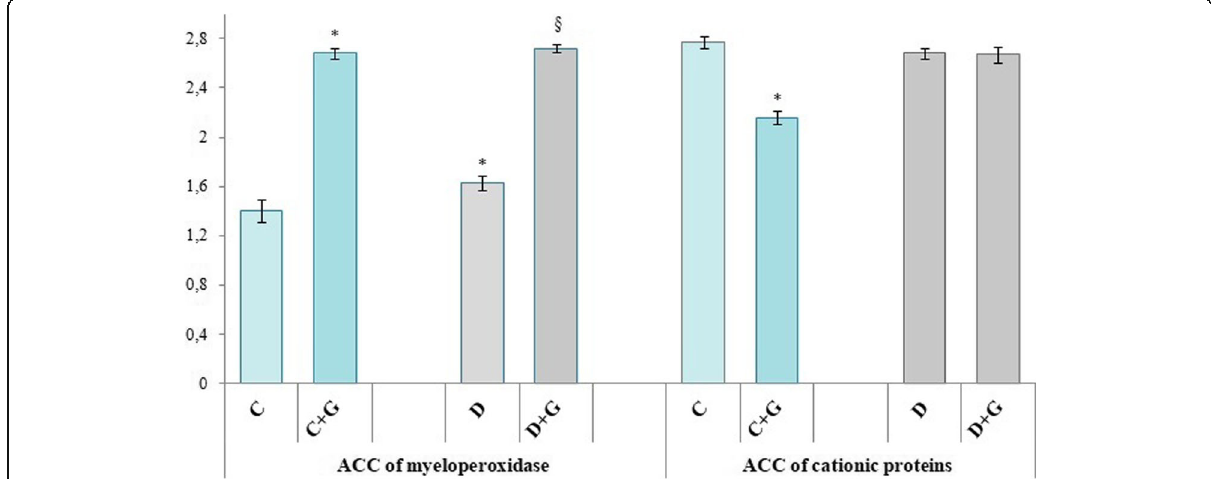
Fig. 4 Changes in average cytochemical coefficient (ACC) of myeloperoxidase and cationic proteins under Galega officinalis extract administration in normal conditions and in the case of experimental diabetes mellitus